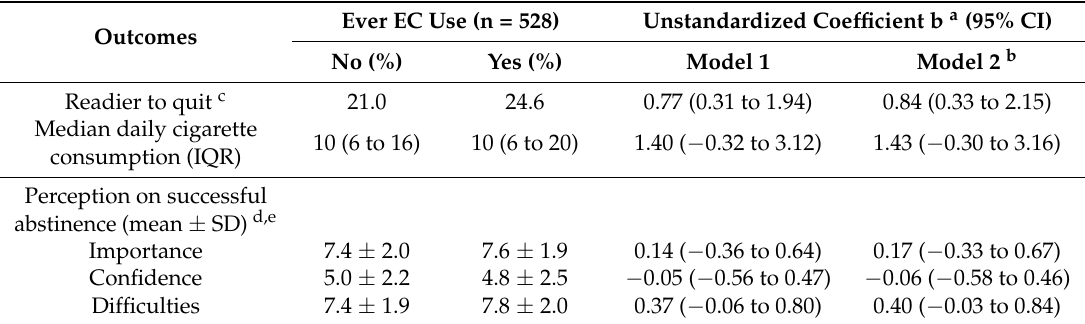
Table 4. Association of quitting and smoking outcomes at the 6-month follow-up with ever EC use at 1-week follow-up in